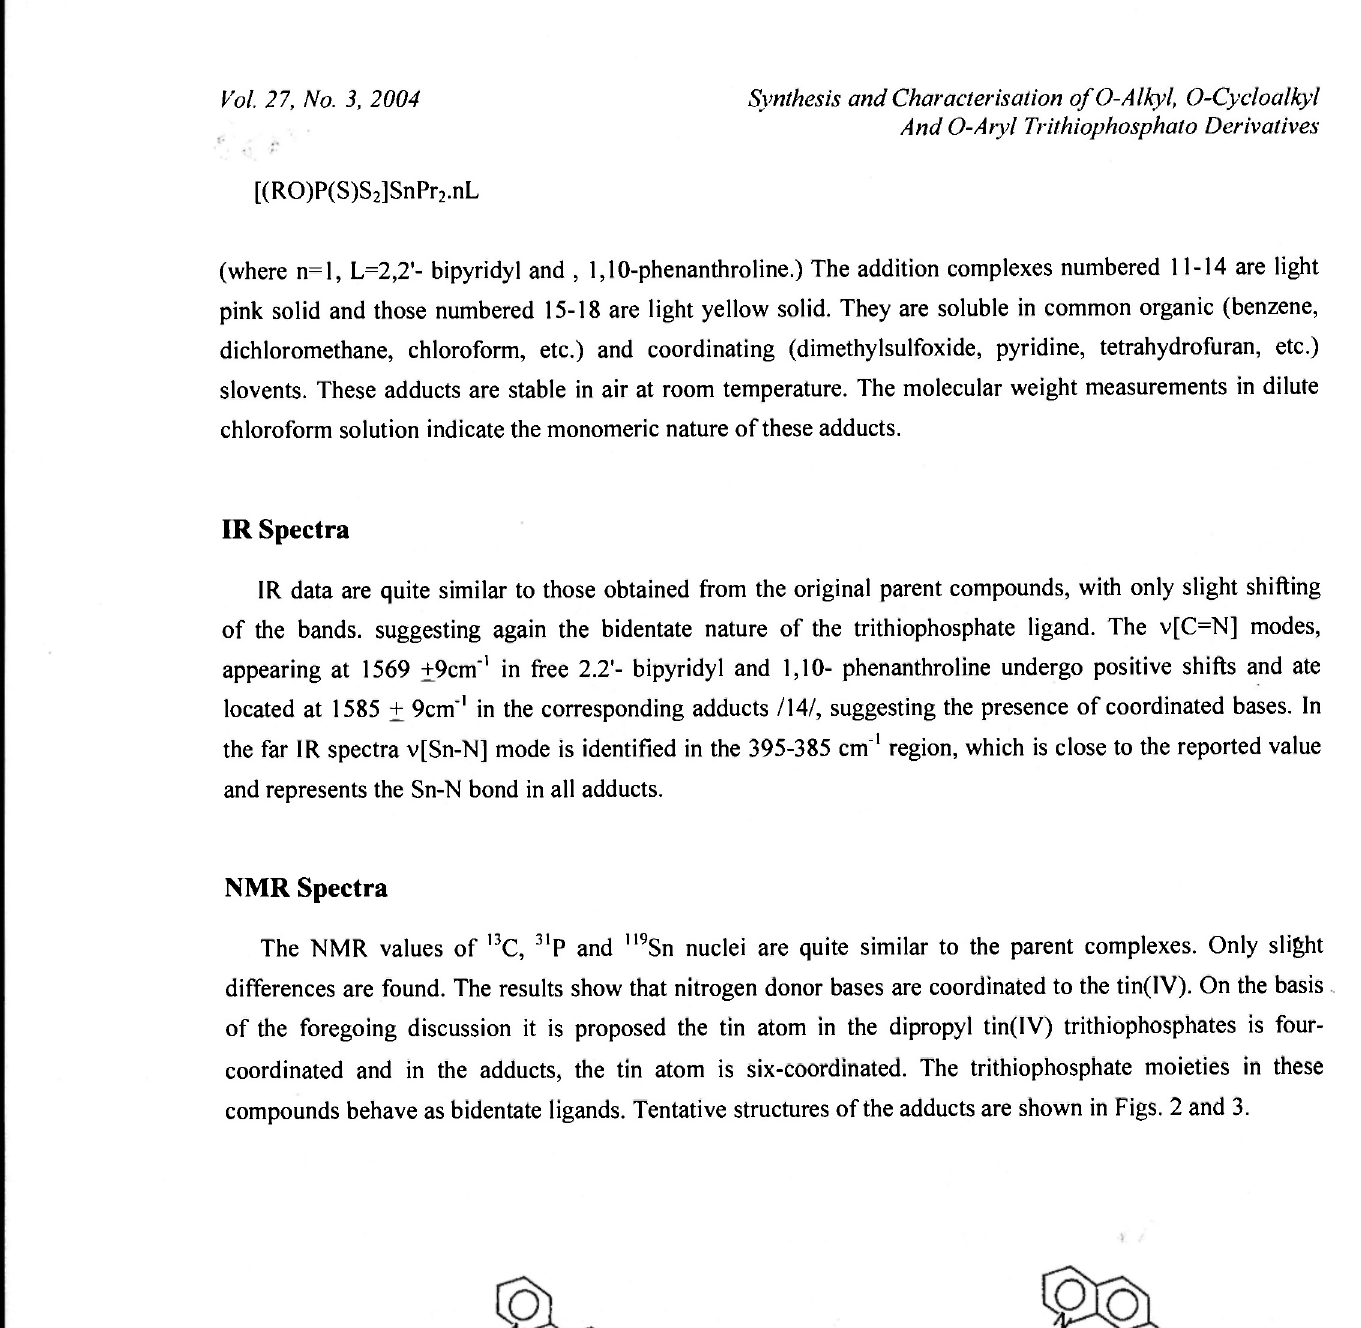
Fig. 2: Structure of Pr 2 Sn[S 2 (S)P(OR)]C 10 H 8 N 2 Fig. 3: Structure of Pr 2 Sn[S 2 (S)P(OR)]C l2 H 8 N